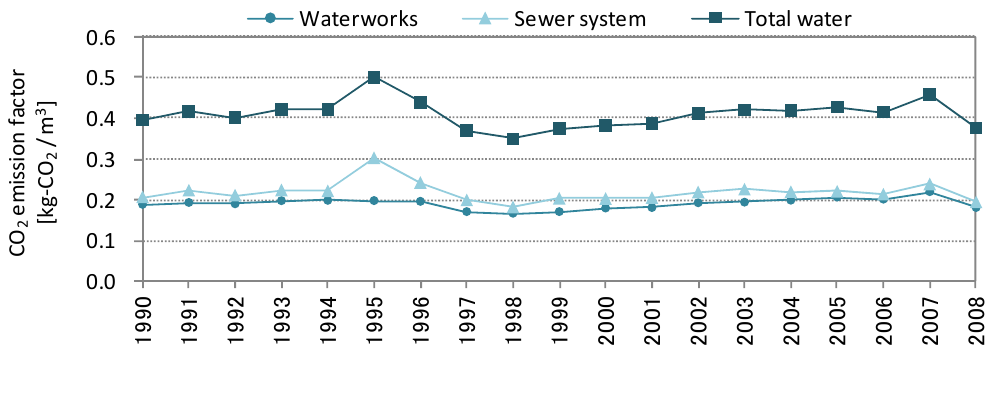
Figure 8. CO emission factor of water in Japan incorporating the generating end electricity 2